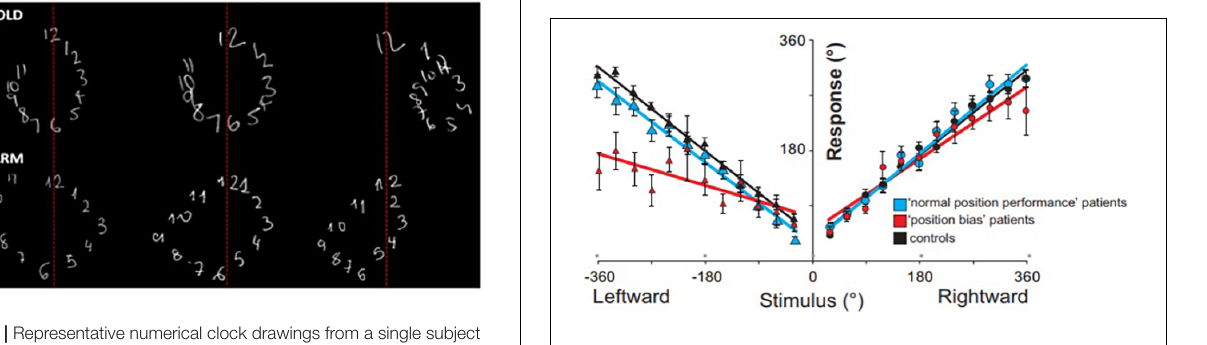
FIGURE 5 | Position task results: grouped response–stimulus position performances are shown for patients with a position bias (red; ‘patients), patients with normal performance (blue; control patients), and age-matched controls (black line). Position bias was calculated for each stroke patient from the subjective response–stimulus position performance regressions, by dividing the leftward regression slope by the rightward regression slope. Vertical bars represent standard errors of the